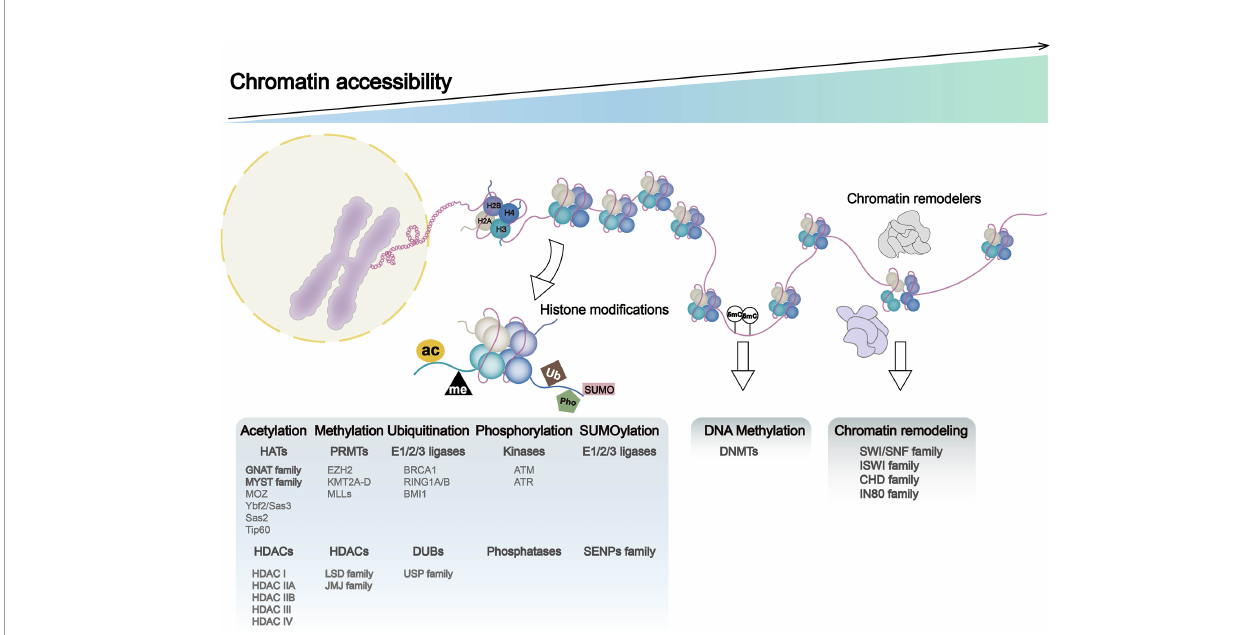
FIGURE 1 | Chromatin dynamics in genome: chromatin accessibility, histone modi fi cation, DNA methylation, and chromatin remodeling. DNA entangles histones (H2A, H2B, H3, and H4) to form nucleosomes, the basic functional unit of chromatin. Nucleosome occupancy in the genome, histone modi fi cations, DNA methylation, and chromatin remodelers leads to alternations in chromatin accessibility, which regulates processes such as gene transcription and translation. Histone modi fi cations include histone methylation, acetylation, ubiquitination, phosphorylation, and SUMOylation, with histone-modifying enzymes and associated gene expression abnormalities playing a major role in these processes. Chromatin remodeling complexes include SWI/SNF, ISWI, CHD, and IN80.